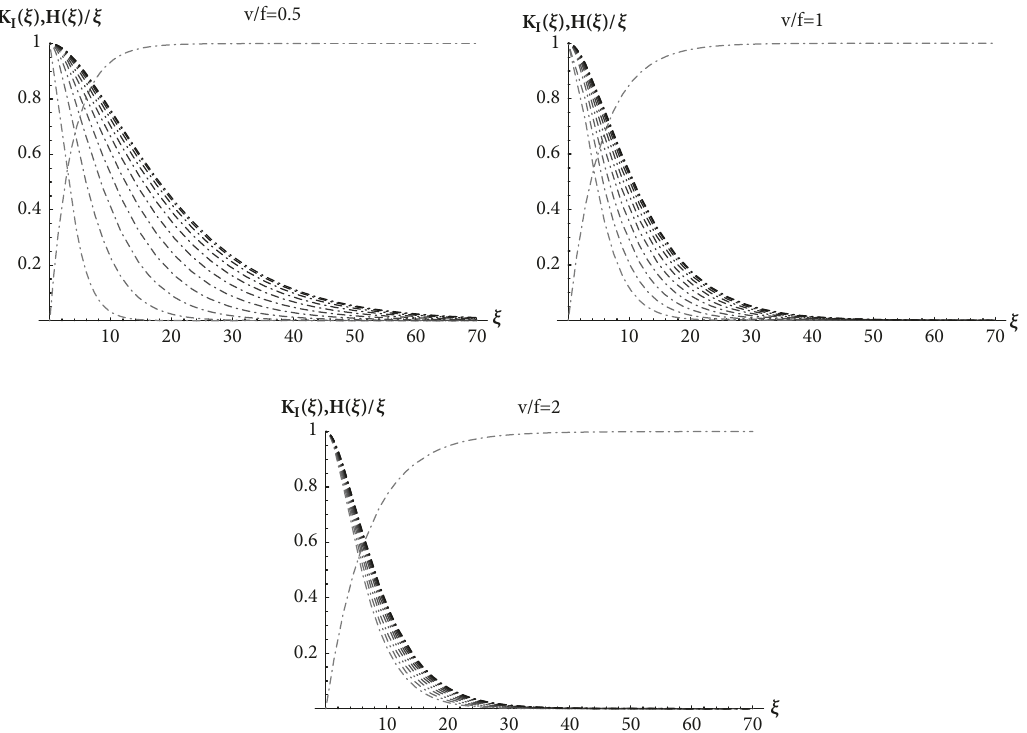
Figure 2: 𝐾 퐼 and 𝐻/𝜉 are shown for 𝑁 = 10 , 𝜆 = 0 . In each graph, 𝐾 퐼 < 𝐾 퐼+1 (1 ≤ 𝐼 ≤ 𝑁 = 10) at any 𝜉 . The three graphs correspond to the cases of 𝑓/ V = 0.5 , 𝑓/ V = 1 , and 𝑓/ V = 2 , respectively.